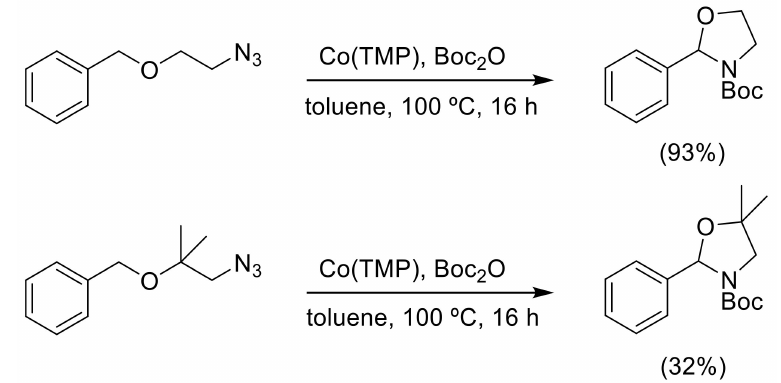
Scheme 59. Catalytic formation of oxazolidines.